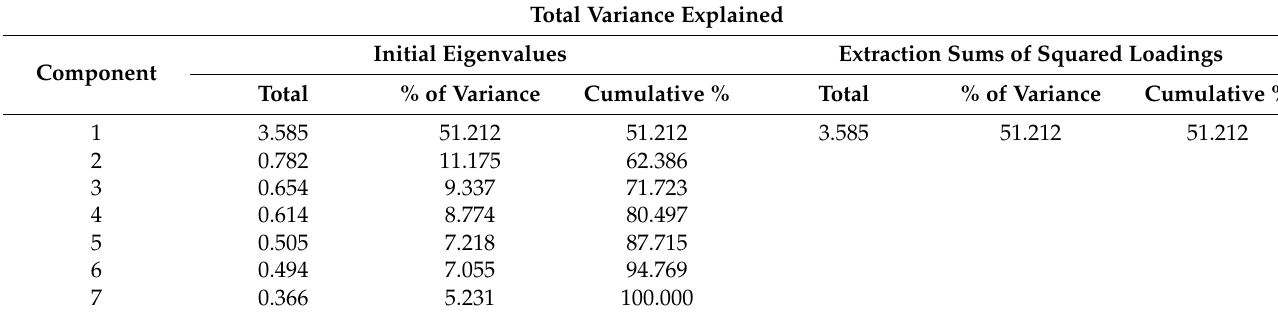
Table 7. Total variance explained (dependent